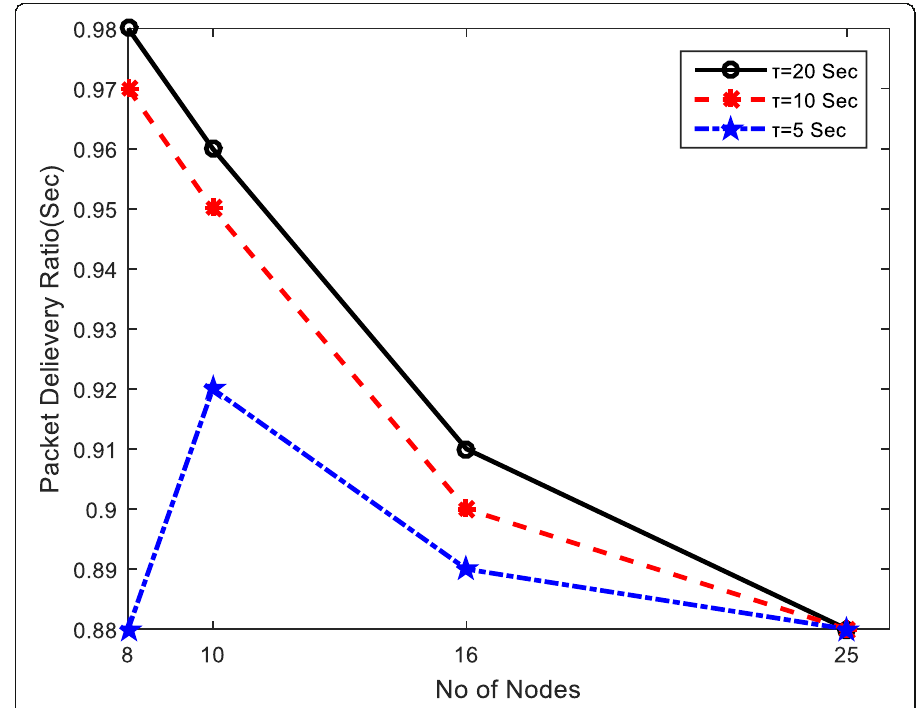
Fig. 15 Packet delivery ratio of T-OLSR (Packet delivery ratio of T-OLSR ( τ = 20, 10, 5 s; Ф = 2 s))